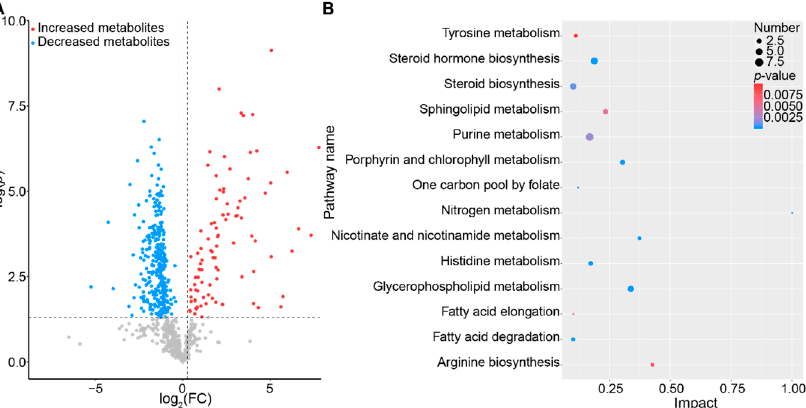
Figure 6. Key metabolic pathways perturbed by CISR. ( A ) CISR perturbed the metabolic profiles of fecal samples in mice, with 405 metabolites significantly changed in comparison with the normal CTRL group (fold change > 1.2, p < 0.05). ( B ) Pathway enrichment analysis of differentially expressed metabolites.